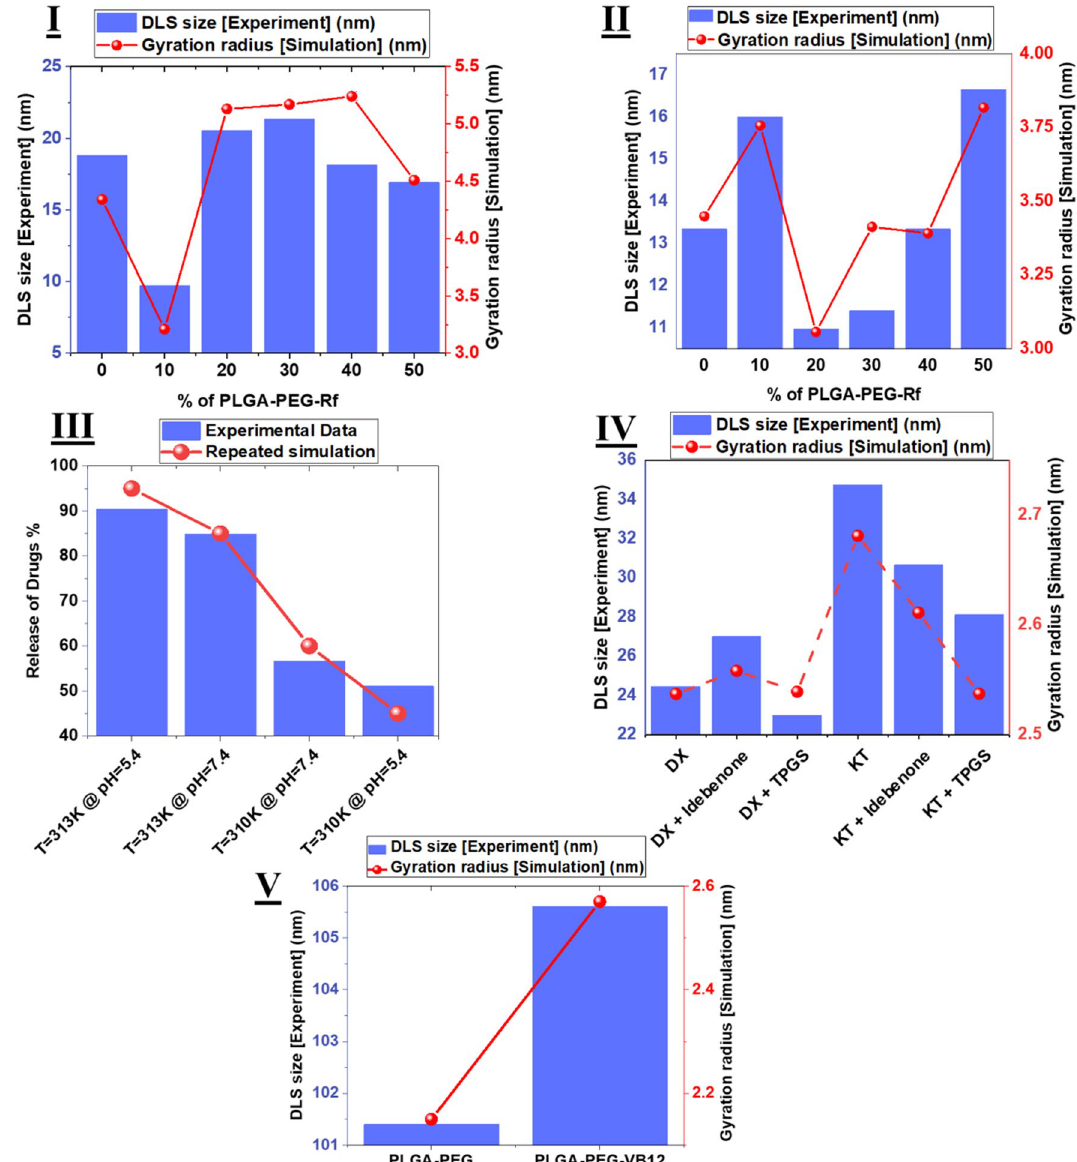
Figure 1. Model of experimental validations. ( I ) and ( II ) Comparison of simulation data and laboratory data obtained from Dynamic Light Scattering (DLS) test for simulations of polymers with PLGA 4.5 kDa -PEG 2 kDa and PLGA 3 kDa -PEG 2 kDa chains, respectively. Which have been published in RSC and ACS journals, respectively. ( III ) This graph is also a comparison of the release rates for PLGA-PEG-PLGA nanostructures and Chrysin drug at the different Temprature and pH, which is the subject of an article in the journal Teylor and Francis. This data is also compared in both simulation and experimental modes. ( IV ) These data are also related to the